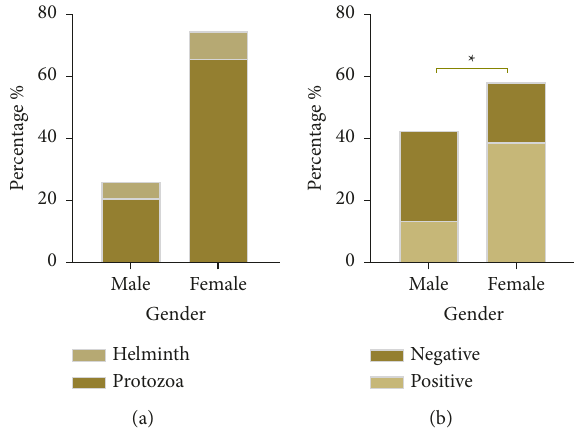
Figure 5: Parasitic infection rate according to gender. Note .